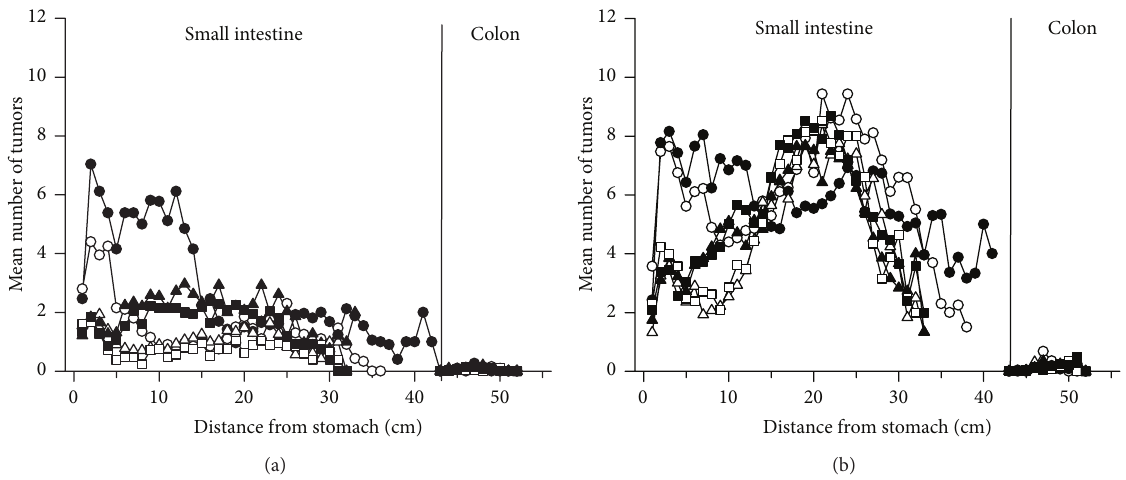
Figure 4: Localization of tumors along the small intestine and colon. This is shown for pooled female and male Apc Min/+ X Lep ob/ob mice ( I ), Apc Min/+ X Lep ob/wt ( 󳵻 ) and Apc Min/+ X Lep wt/wt mice ( ◻ ) on a 10% fat diet (open symbols) or a 45% fat diet (filled symbols) treated with (a) 0.9% NaCl or (b) PhIP. The tumor position is given as distance from the stomach measured in cm. Mean number of tumors/cm intestine for the mice in each experimental group was scored. 𝑛 = 10 –17